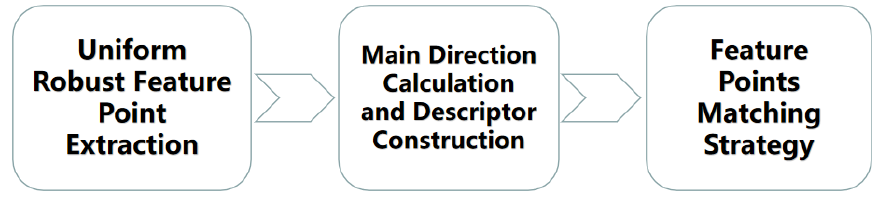
Figure 1. The workflow of the proposed algorithm.